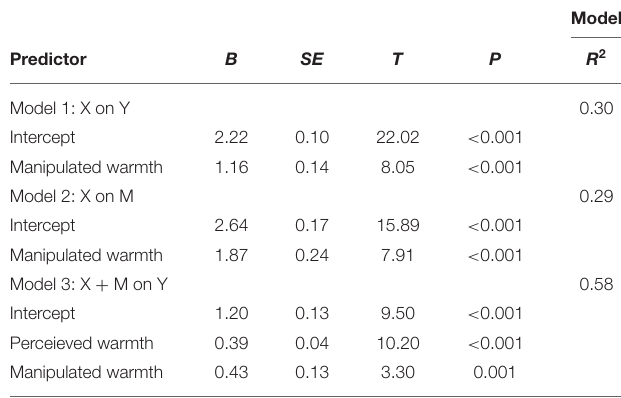
TABLE 9 | Mediated regression analysis testing the effect of manipulated warmth on attributed trustworthiness mediated by perceived warmth in study Model